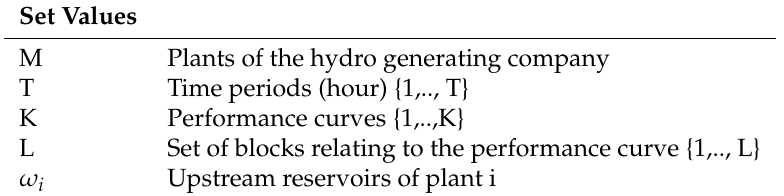
Table A1. Set values.